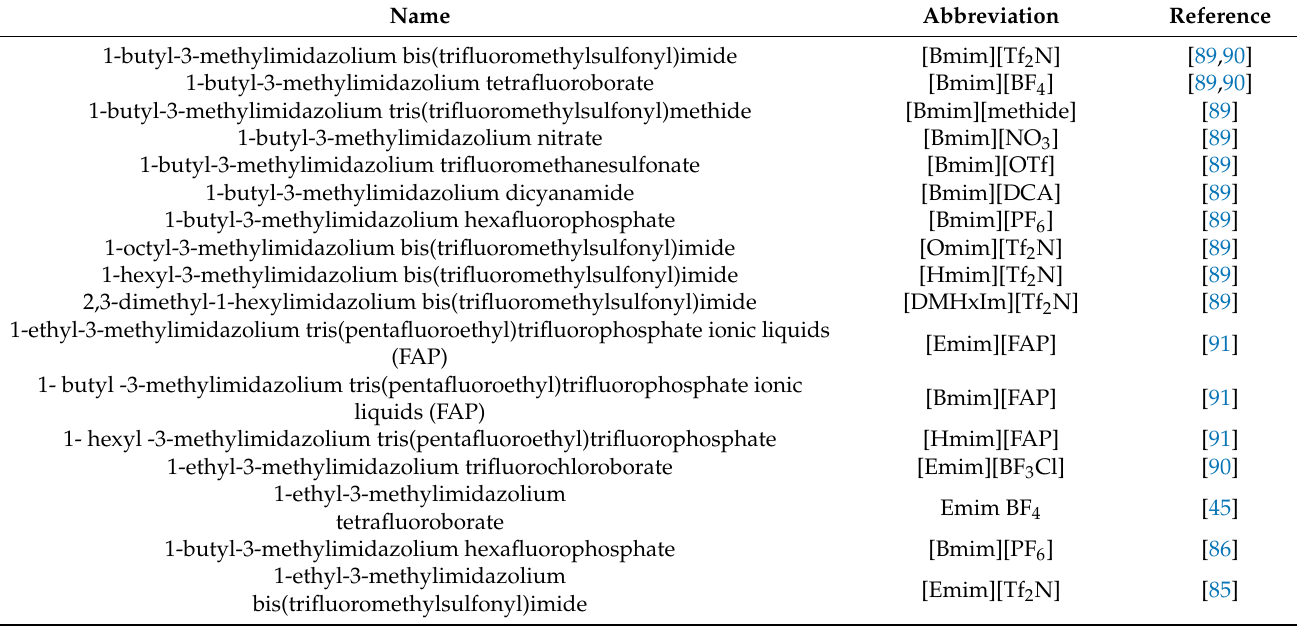
Table 3. List of ionic liquid